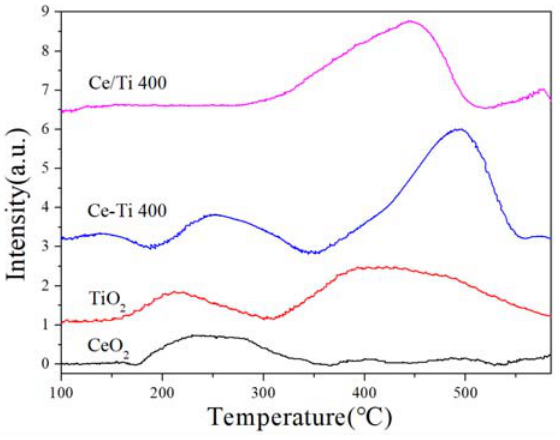
Figure 7. NH 3 -TPD profiles of Ce-Ti-400 and Ce/Ti-400.